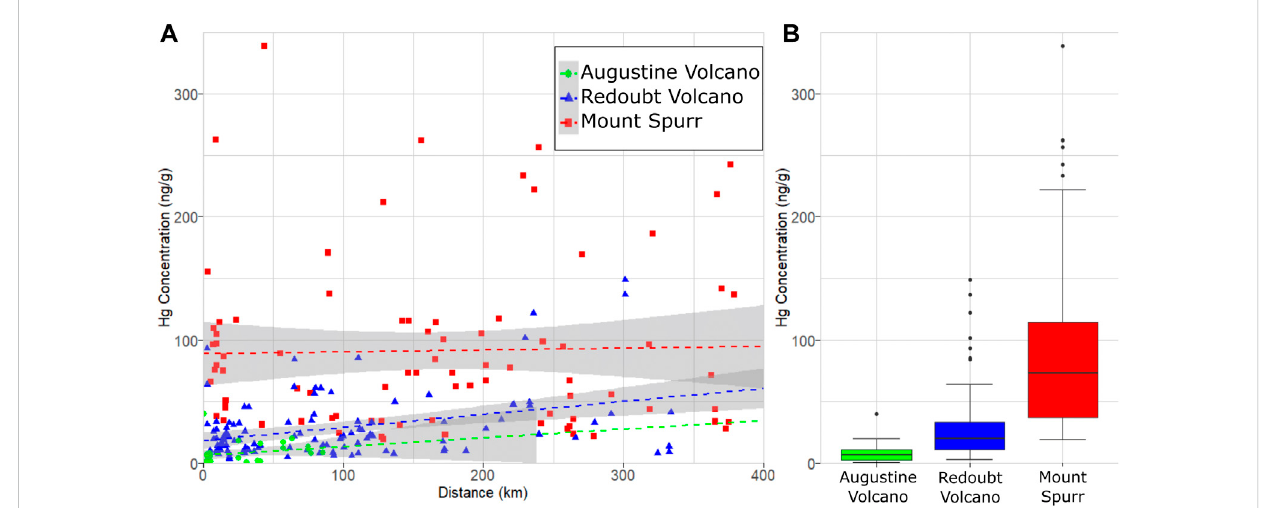
FIGURE 4 Hg concentration measured as PBM on volcanic ash from Mount Spurr (1992), Redoubt Volcano (2009) and Augustine Volcano (2006) volcanic eruptionsinAlaska. (A) PBMonashasafunctionofashdepositiondistancefromtheeruptionvent,withdashedlinesshowinglinearregressions.Notethe high variance in measured PBM for each eruption and occurrence of sample Hg concentrations plotting outside gray (95% con fi dence interval) regions indicating no signi fi cant relationship between Hg concentration and distance for these eruptions. (B) Box plot showing the observed difference in median Hg concentration (thick lines), interquartile ranges (colored boxes), minimum/maximum values (horizontal caps), and outliers (black circles).